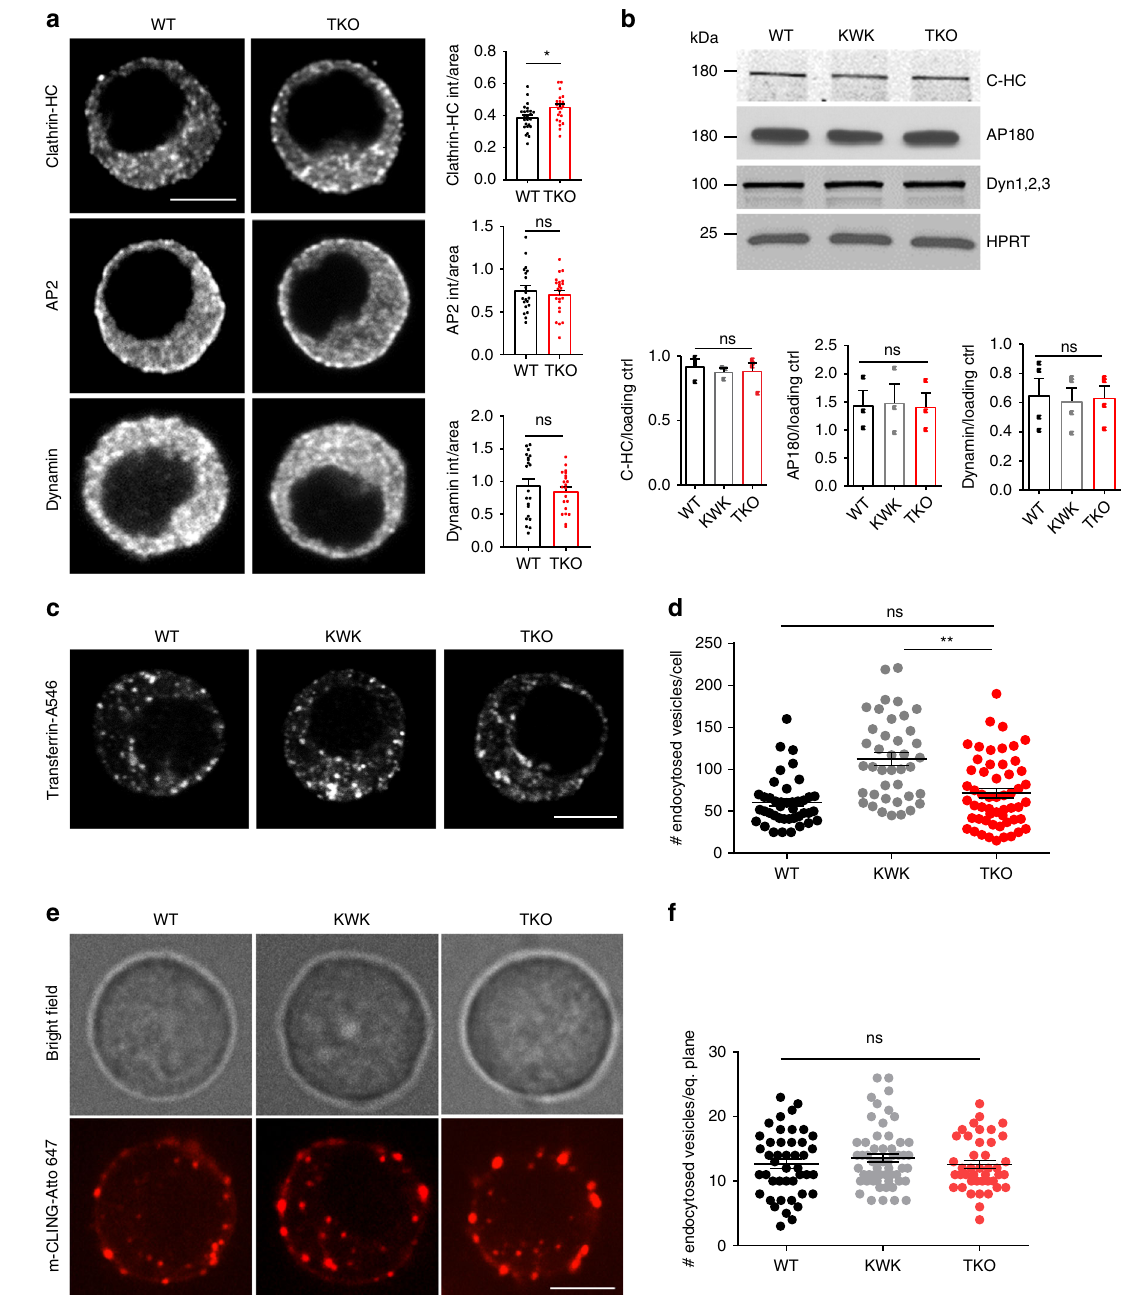
Fig. 5 Minor endocytic defects in the absence of endophilin in chromaf fi n cells. a Immuno fl uorescence for clathrin heavy chain (HC), adaptor protein